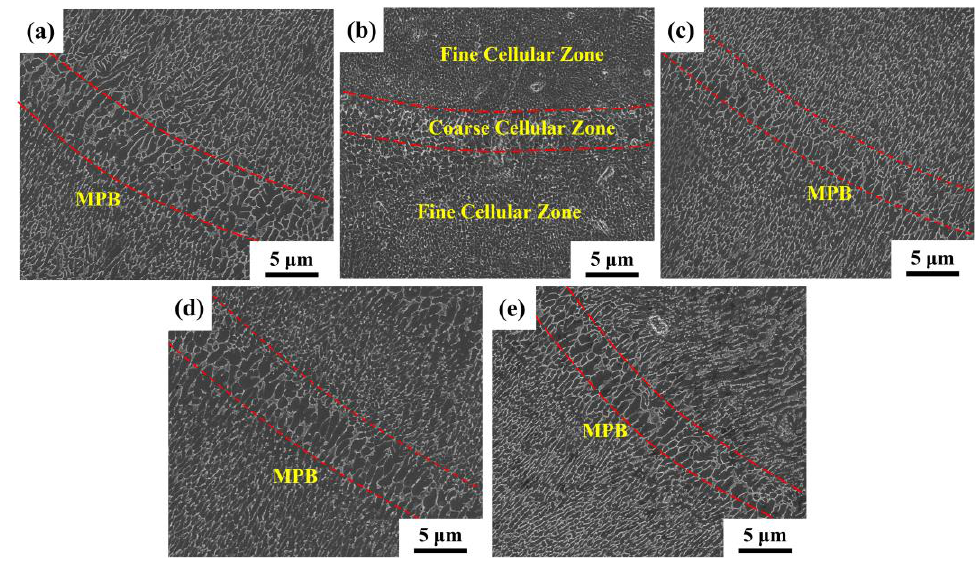
Figure 7. SEM images of SLMed samples: ( a ) S0; ( b ) S1; ( c ) S2; ( d ) S3; ( e ) S4.